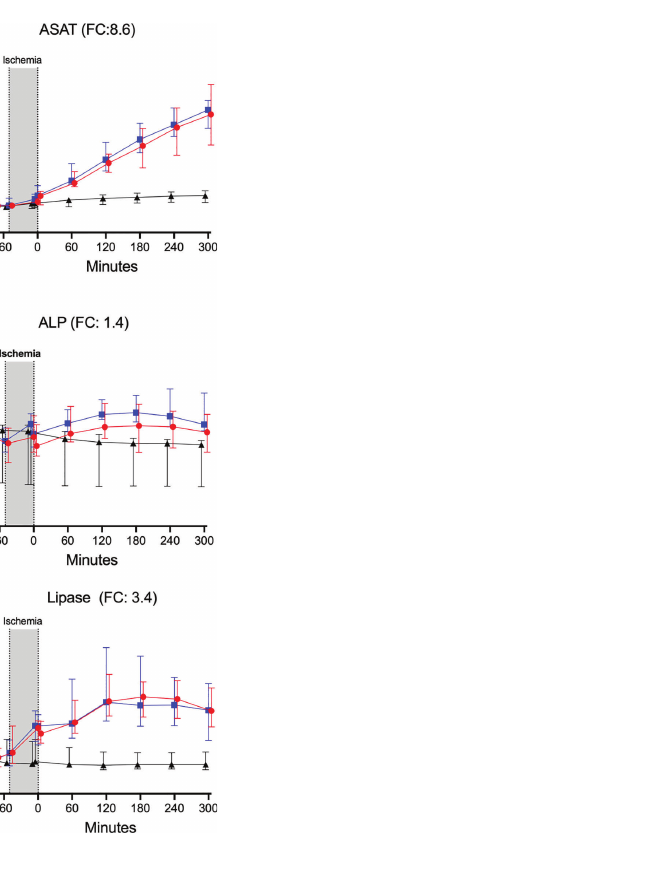
FIGURE 8 | Biochemical and organ damage markers II. (A) Alanine aminotransaminase (ALAT), (B) aspartate aminotransferase (ASAT), (C) gamma-glutamyl transferase ( g GT), (D) alkaline phosphatase (ALP), (E) bilirubin, and (F) lipase were measured in serum of 24 piglets undergoing clamping of the thoracic aorta at the Th8 level. Upfront 12 piglets received human saline intravenously and 12 received C1-INH (250 IU/ kg), respectively. Three sham animals received thoracic opening without clamping. Reperfusion started at 0 minutes and lasted 5 hours. Longitudinal time data are expressed as median and interquartile range. “ Ischemia ” indicates the 45 minutes period of clamping. NaCl and C1-INH-groups were combined when there were no differences in the fold change (FC) calculation. FC is the change from before cross-clamp onset to maximum